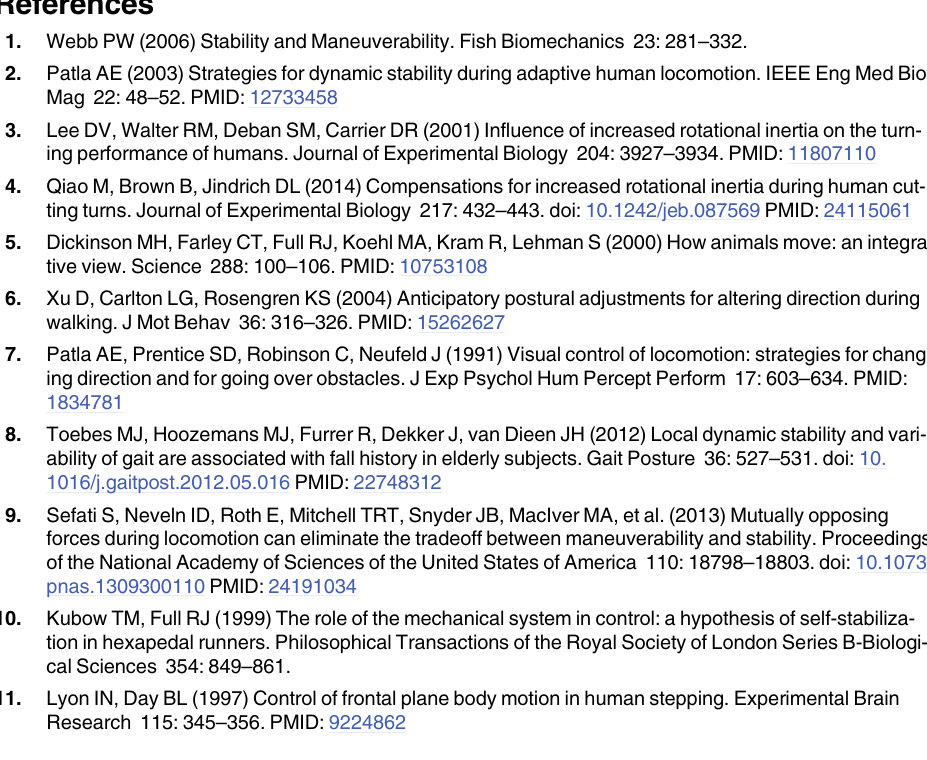
S1 Table. Individual subjects ’ data for demographics and